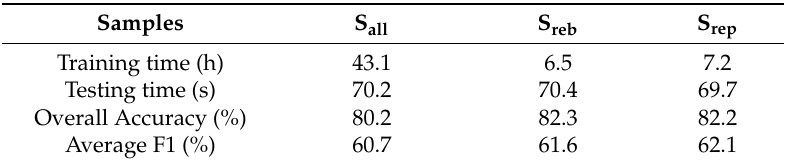
Table 5. The training time, testing time, overall accuracy and average F1 of our method for different samples using the re-balancing